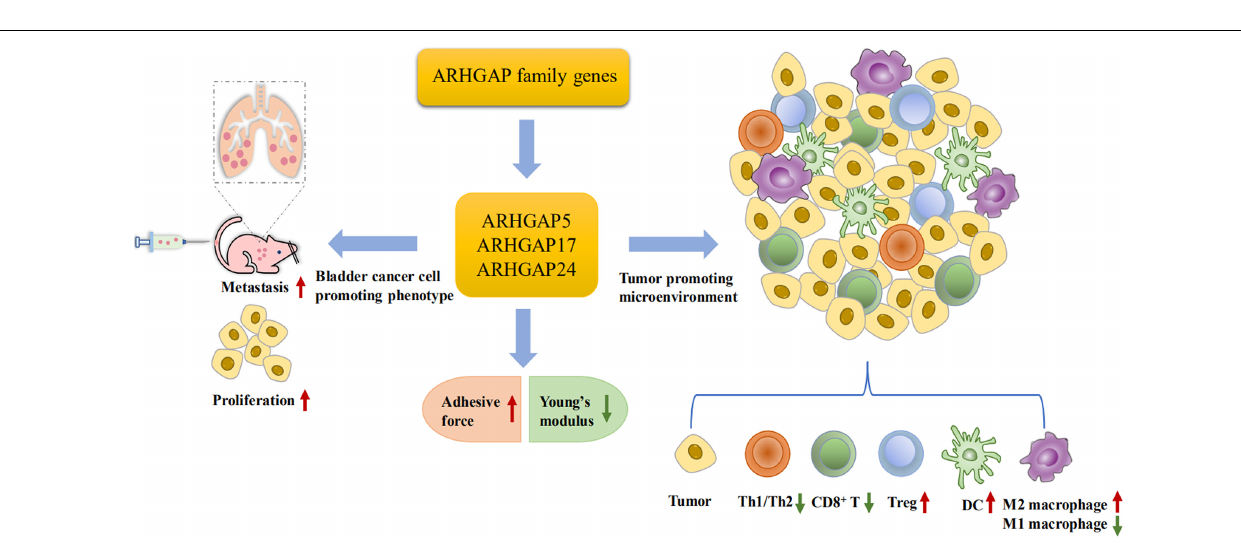
Frontiers in Cell and Developmental Biology |